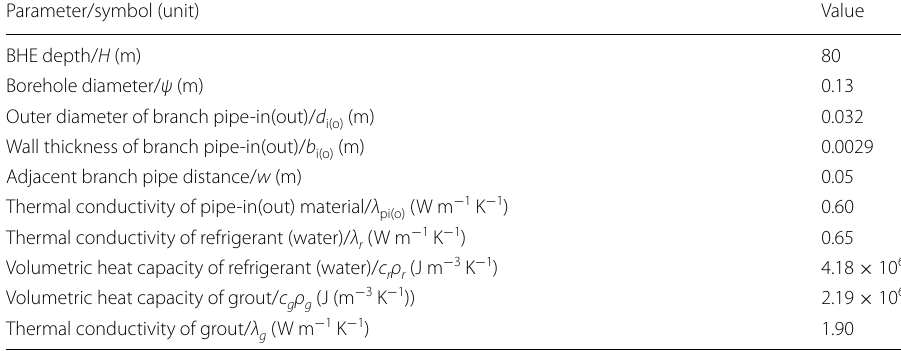
Table 2 Design parameters of 2U-type BHE Parameter/symbol